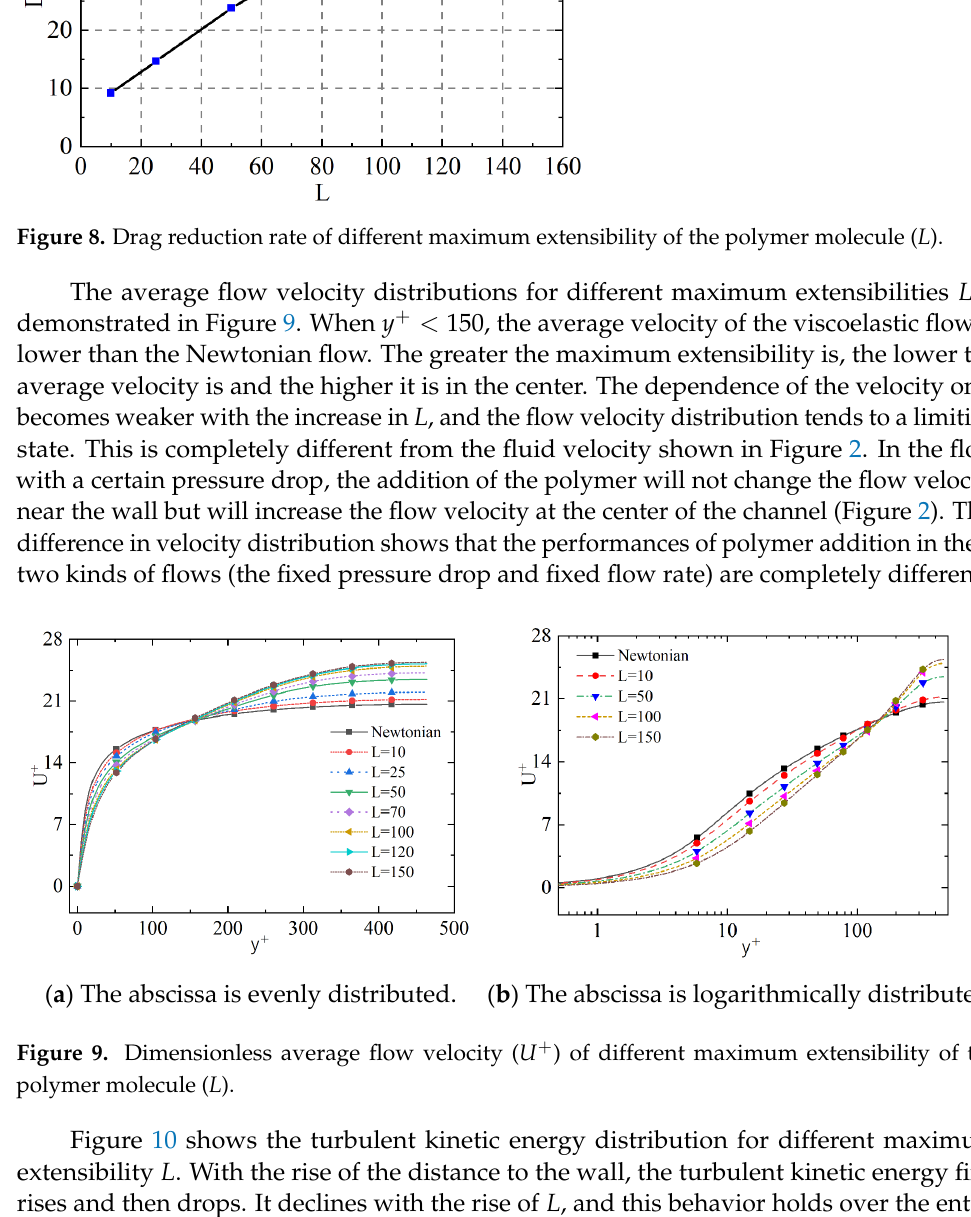
Figure 9. Dimensionless average flow velocity ( U + ) of different maximum extensibility of the polymer molecule ( L